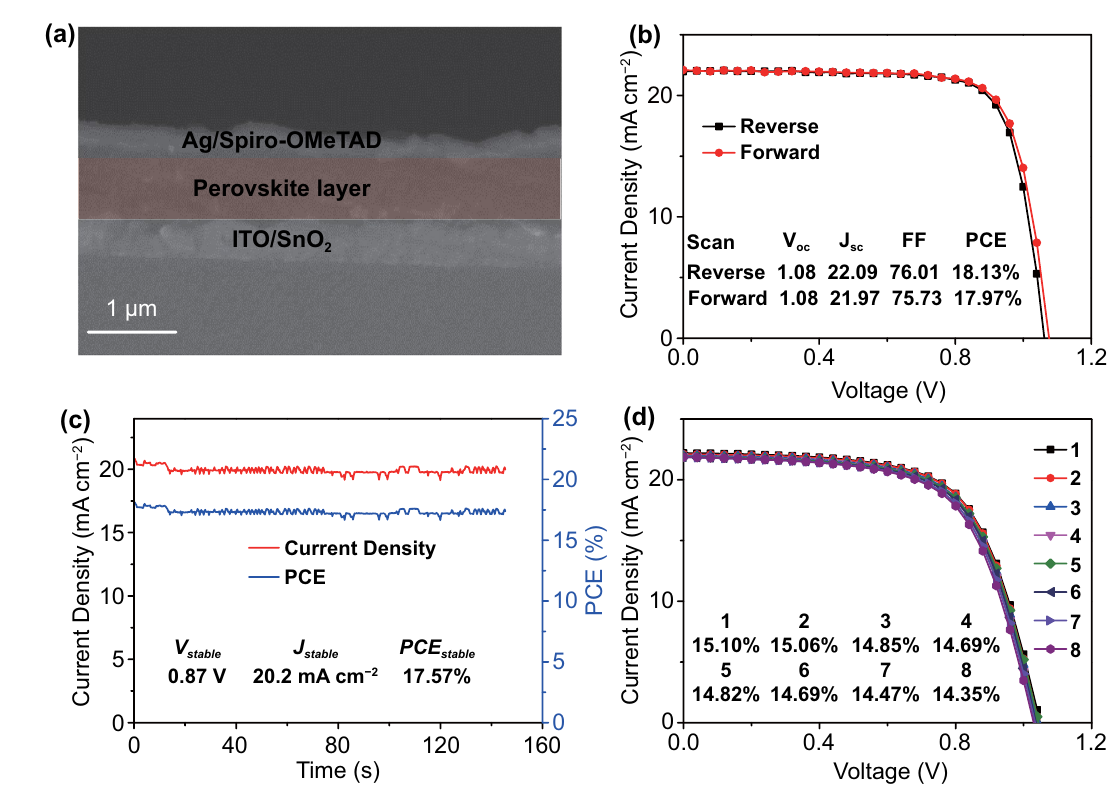
Fig. 5 a SEM cross-sectional image for a fully slot-die coated PSC except for the electrode. b J–V curves of the champion cell under reverse and forward scan. c Steady-state PCE of the champion cell. d J–V curves of 8 PSCs with 1 cm 2 area fabricated by fully slot-die coating except for the